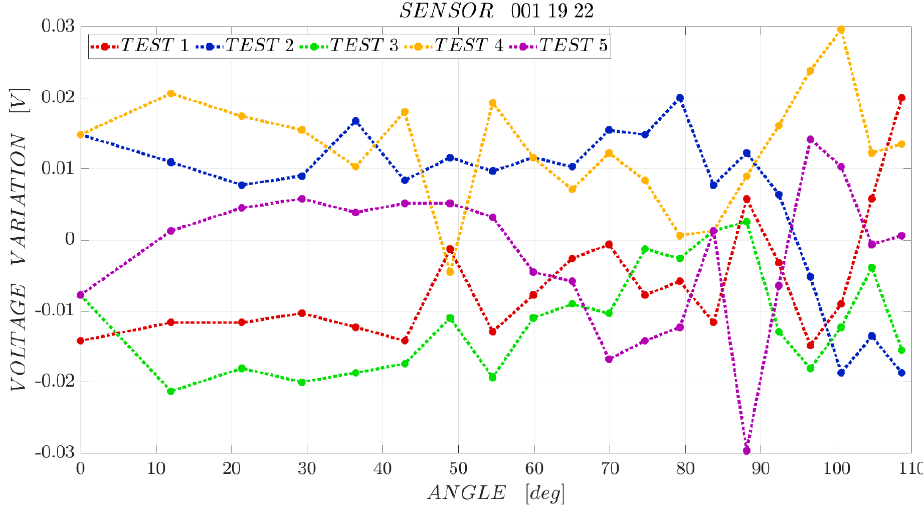
Figure 20. Sensor 001 19 22: deviation from the average curve (backward path).